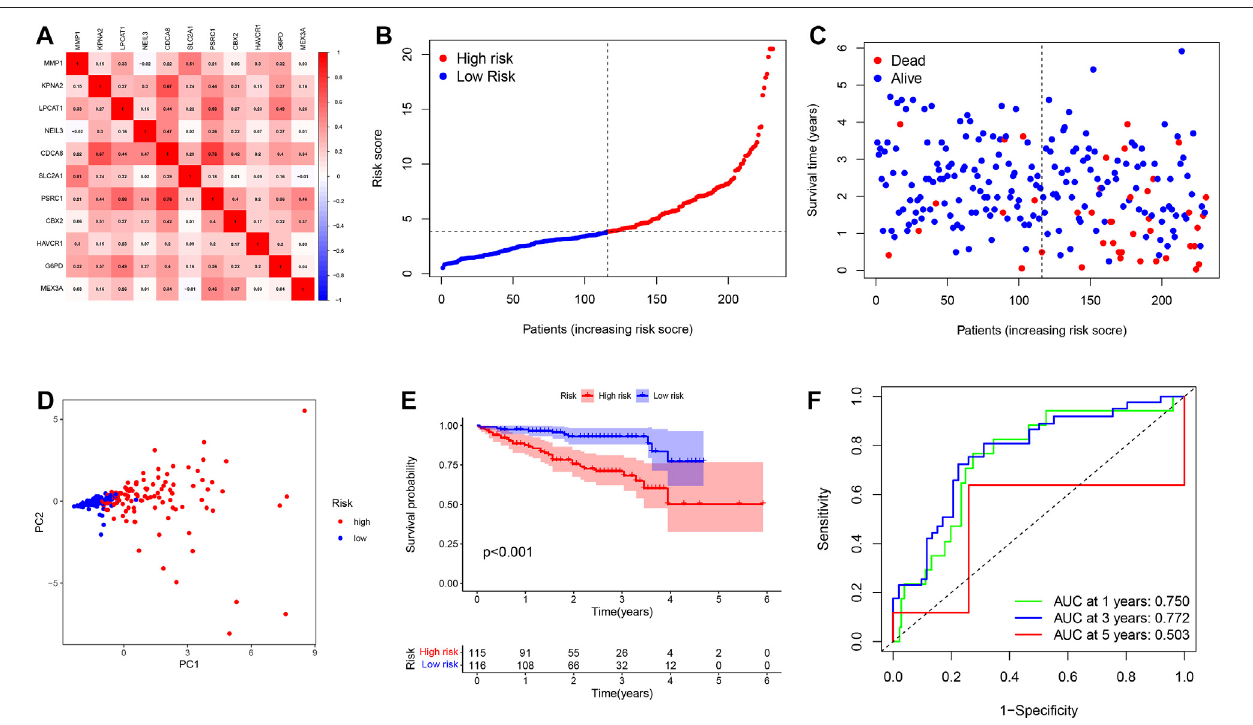
FIGURE 5 | Validation of a pyroptosis risk signature in the ICGC cohort. (A) Spearman correlation analysis of eleven genes in the ICGC cohort. (B) The distribution andmedianvalueoftheriskscores. (C) Patientsurvivalstatusdistributioninthehigh-andlow-riskgroups. (D) PCAplotanalysis. (E) Kaplan-Meieroverallsurvivalcurves for patients assigned to high- and low-risk groups based on the risk score. (F) ROC curve showing the prognostic value of pyroptosis risk scores on the 1-, 3-, and 5 years survival